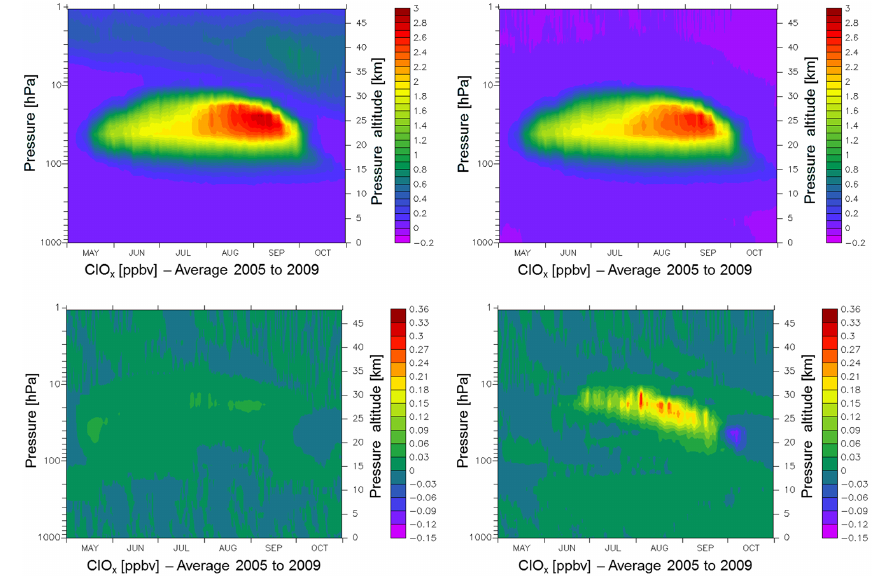
Figure 3. Chlorine activation – time series of ClO x in ppbv in the standard simulation during Antarctic winter and spring averaged over 80 ◦ to 90 ◦ S and the years 2005 to 2009 (top left) and contribution of liquid particles (top right), additional contribution by activation on NAT particles (bottom left) and additional contribution by activation on ice particles (bottom right). ClO x is defined as the sum of ClO + OClO + HOCl + 2Cl 2 + 2Cl 2 O 2 . Note that the colour bars have different units.